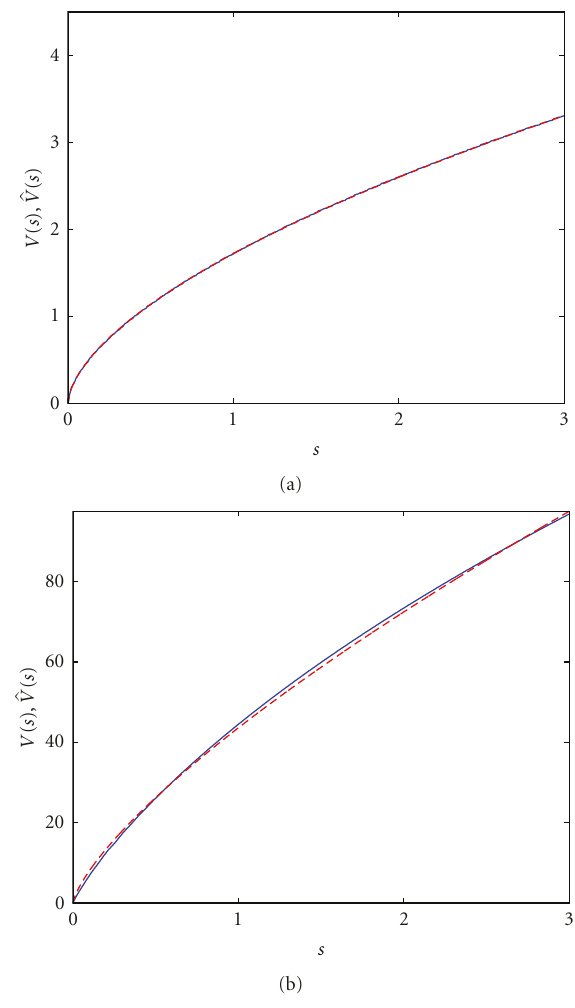
Figure 1: (a) Comparing V (blue) with (cid:12) V (red, dashed) for the lightly smoothed flow. (b) Comparing V (blue) with (cid:12) V (red, dashed) for the heavily smoothed